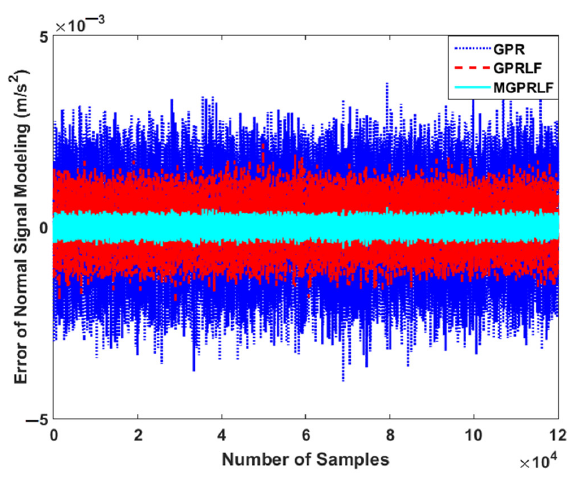
Figure 4. Error of system modeling using the proposed MGPRLF, GPRLF, and GPR algorithms.